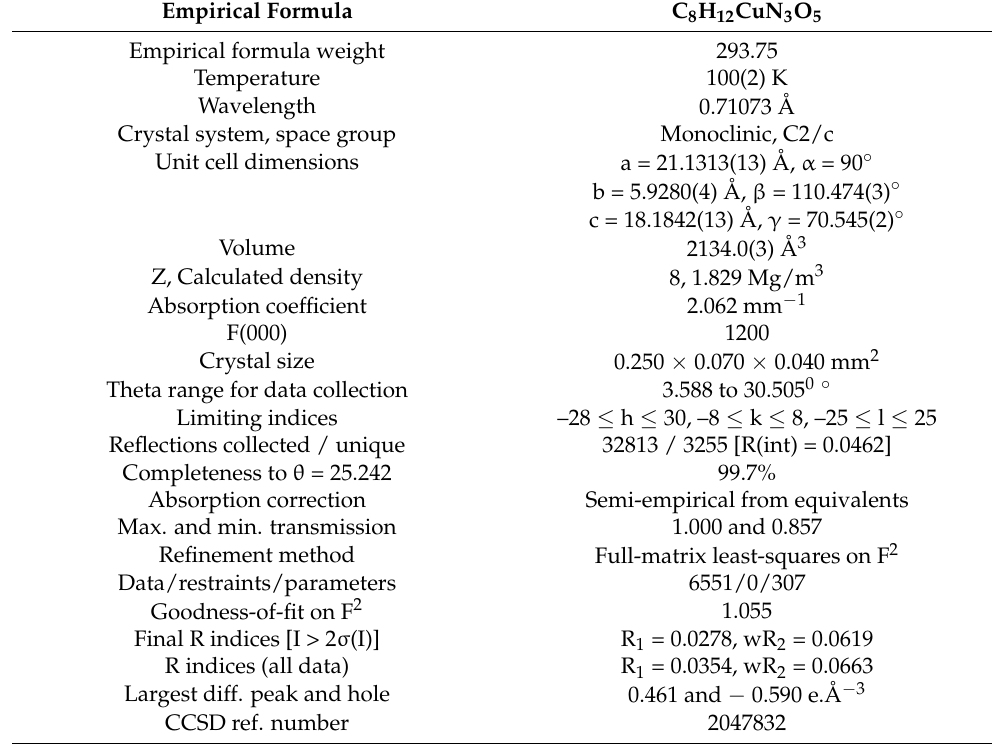
Table 1. Crystal data and structure refinement for {[Cu 2 ( µ 4 -EDTA)(Him) 2 ] · 2H 2 O} n ( 1